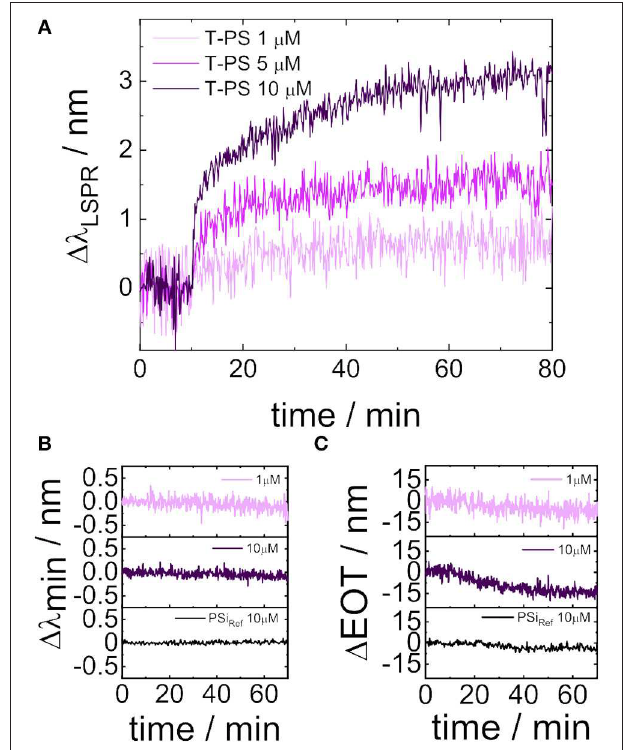
FIGURE 7 | Real-time monitoring of the interaction of thiol-terminated polystyrene with the hybrid sensor comprising two different sensor surfaces (gold nanostructure / porous silicon). (A) Shift in the LSPR wavelength of the gold nanostructure in response to immersing the sensor in solutions of thiol-terminated polystyrene in toluene (three different concentrations). (B) Changes in the position of an interference minimum located at ∼ 741nm in toluene upon addition of thiol-terminated polystyrene. (C) Changes in the effective optical thickness of a reference porous silicon film in response to thiol-terminated polystyrene in the immersion